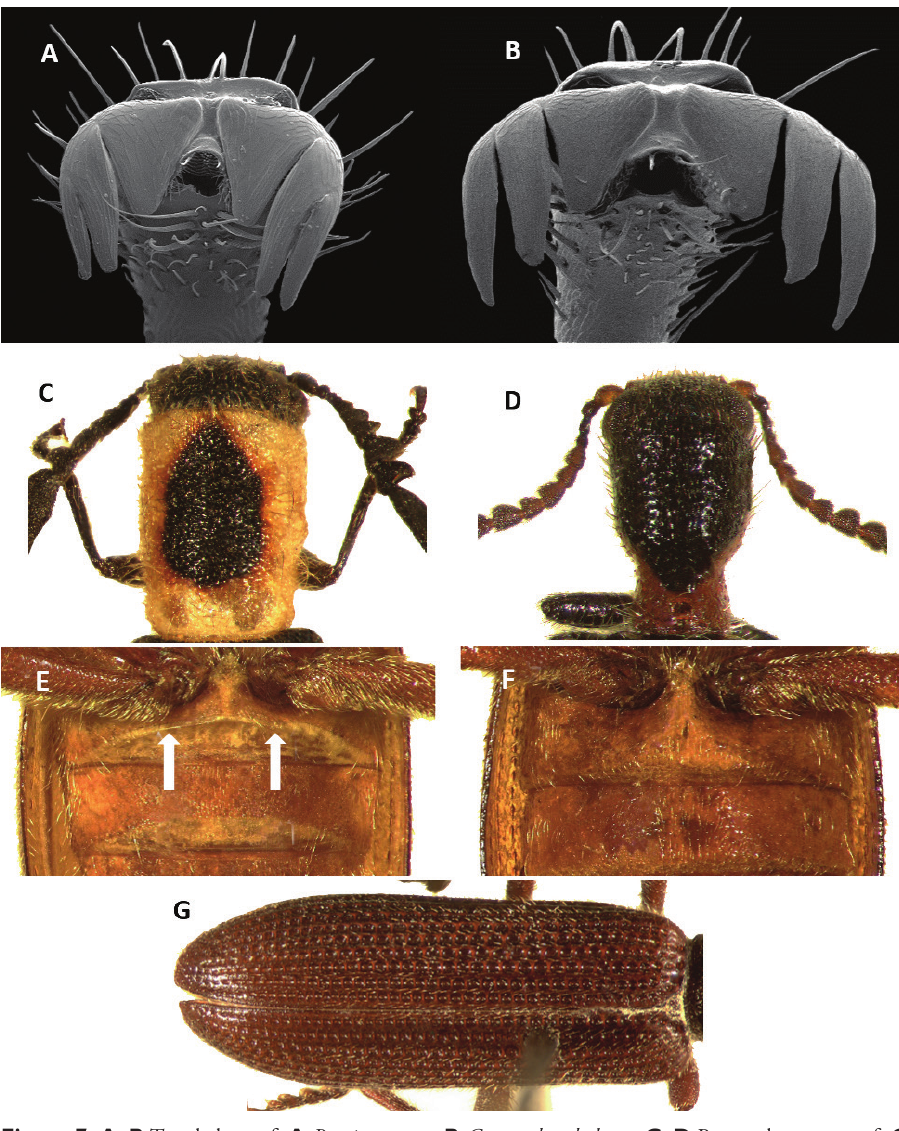
Figure 7. A–B Tarsal claws of: A Bogcia oaxacae B Cymatodera balteata C–D Pronotal structure of: C Monophylla terminata D Barrotillus kropotkini E–F First and second visible ventrite of: E Cymatodera mitae (male), arrows indicate longitudinal carina F Cymatodera mitae (female) G Elytral ground of Le- contella gnara.